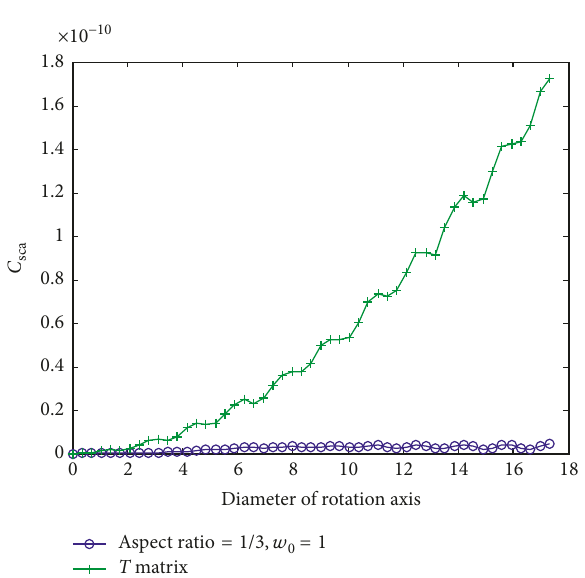
Figure 2: Scattering cross sections of quartz particles ( λ m (cid:31)